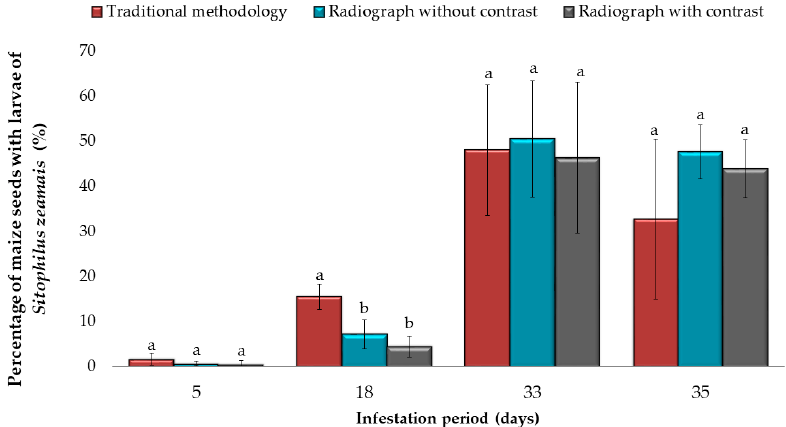
Figure 2. Average percentage of maize seeds infested with larvae of Sitophilus zeamais at 5, 18, 33 and 35 days after infestation, by traditional methods, radiograph without contrast and radiograph with contrast. The bar graph shows the means, and the error bars show the ± SD in each period of infestation (Tukey-Kramer Test, p < 0.05).